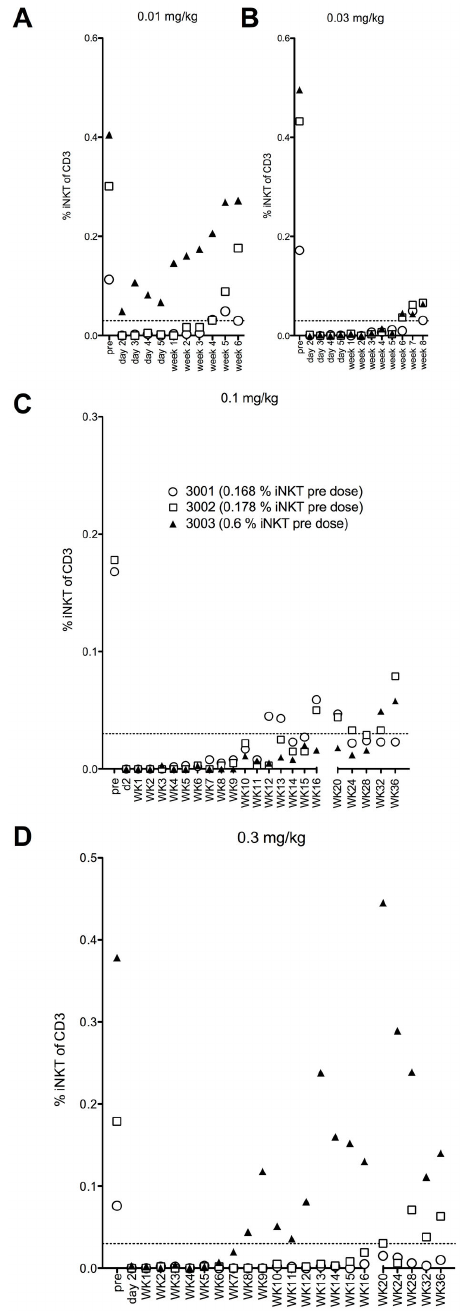
Figure 3. Cynomolgus macaques (n=3 per dose group) were dosed with a single dose of 0.01 mg/kg (A), 0.03 mg/kg (B), 0.1 mg/kg (C) and 0.3 mg/kg (D) of NKTT120, respectively and subsequently bled at indicated time points. Whole blood samples were stained with antibodies against CD3 (SP34.2), CD20 (2H7), TCR Vα24 (C15), CD159a (Z199) and invariant TCR (6B11). Subsequently red blood cells lysed, cells washed and analyzed by flow cytometry. iNKT cells were identified as CD3+, Vα24+, 6B11+ lymphocytes and reported as % of CD3+ cells. doi: 10.1371/journal.pone.0076692.g003 PLOS ONE |